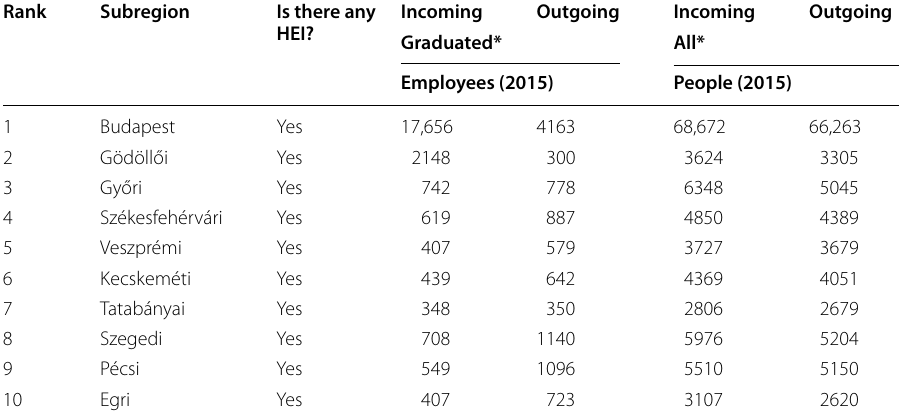
* without loops, it means that the source and the host location must be